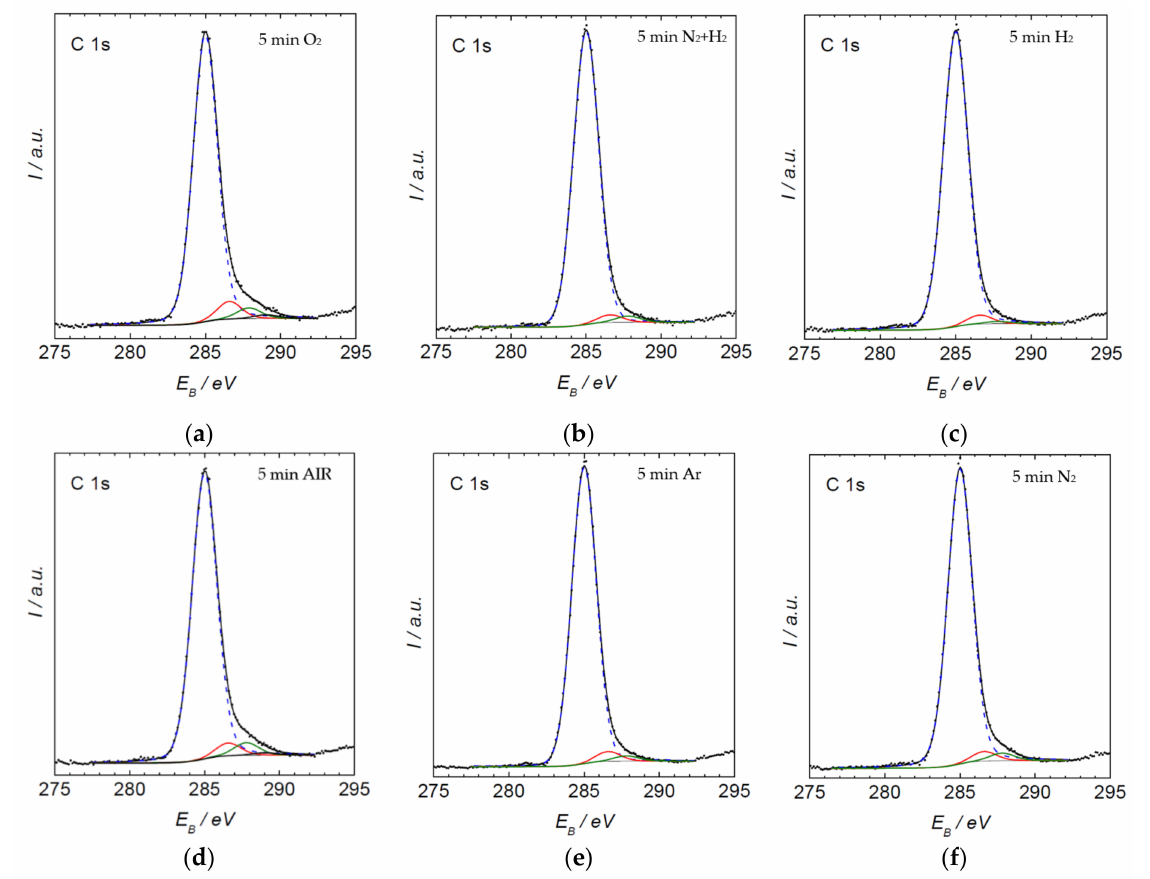
Figure 9. C1s spectrum of 5 min plasma-treated PE powder, treated in air plasma ( a ) oxygen, ( b ) nitrogen + hydrogen, ( c ) hydrogen, ( d ) air, ( e ) argon and ( f ) nitrogen. Blue line C-C bond, red line C-O bond, green line C=O bond, black line O-C=O